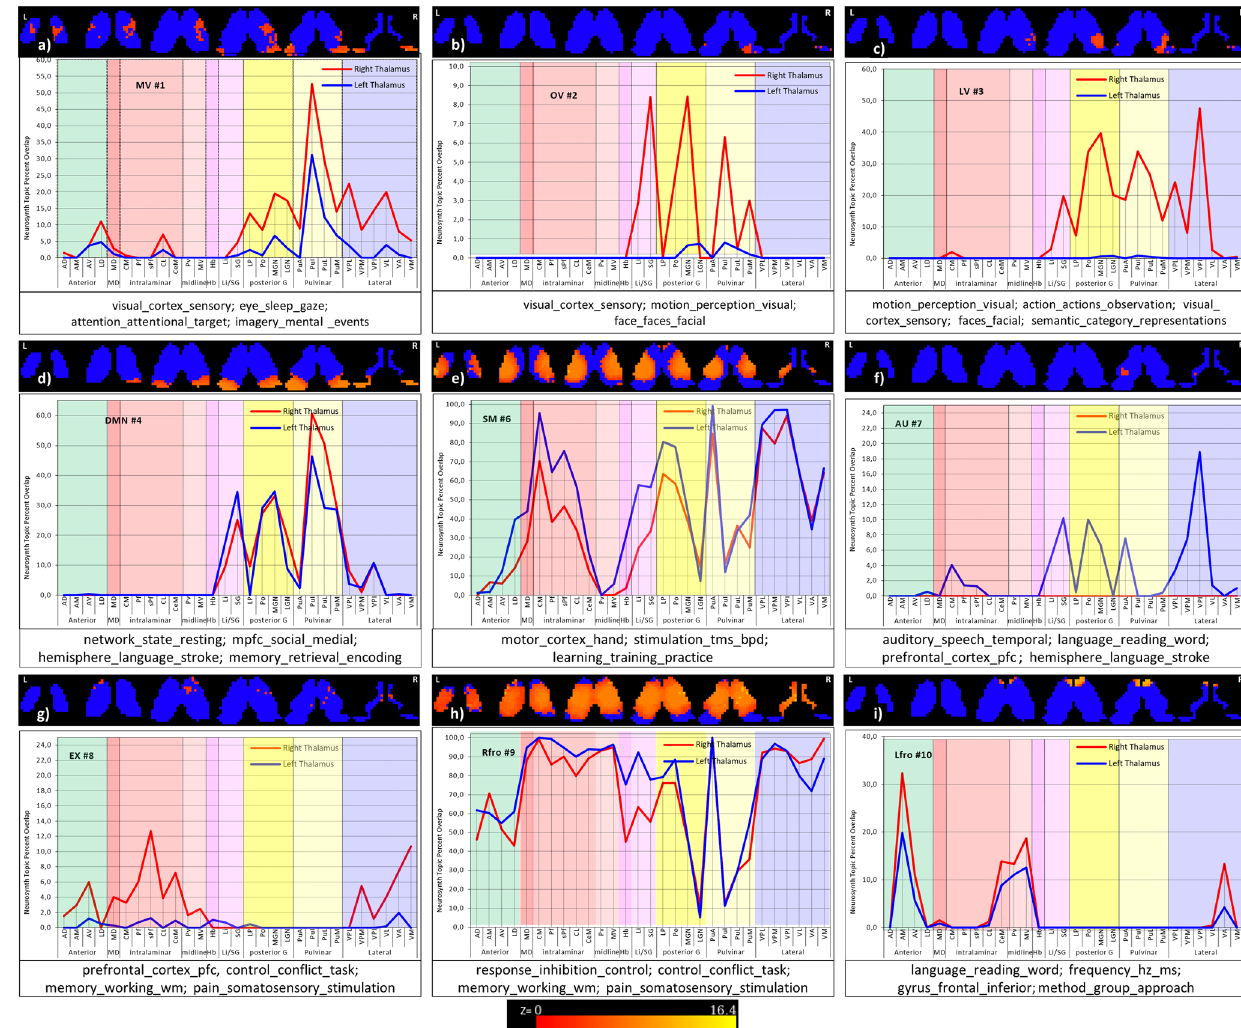
Fig. 9 Large-scale functional network highly correlated neurosynth topic maps within thalamus: each subplot represents a functional network and its highly correlated topic maps (spatially overlaid on six different axial slices, depicting correlation maps with each network). The topic maps were thresholded at z -value 3.1 ( p value 0.001). The graph within each subplot depicts the percent nuclei overlap of highly correlated topic maps (marked in the red circle in the fi gure) with the thalamus. Color scale: same for all the maps (0 – 16.4) across all the networks. The blue color depicts the thalamus mask in the background. a MV #1: 43 visual_cortex_sensory; 45 eye_sleep_gaze; 48 attention_attentional_target; 42 imagery_mental_events; b OV #2: